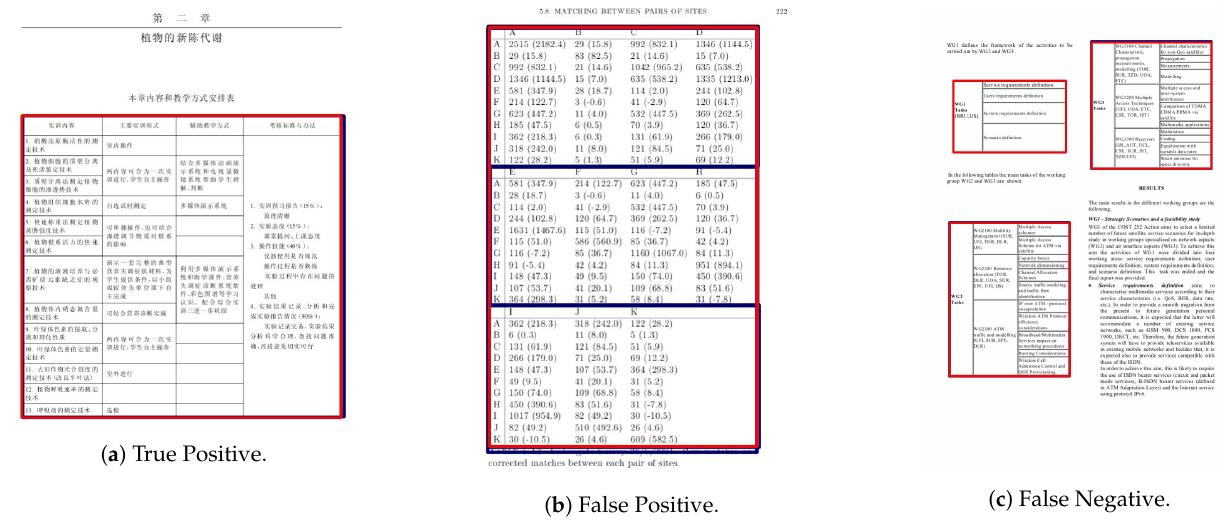
Figure 9. HybridTabNet results on Marmot dataset. ( a – c ) True positive, False positive, and False negative results, respectively. The blue outline shows the predicted table, and the red outline highlights the ground truth